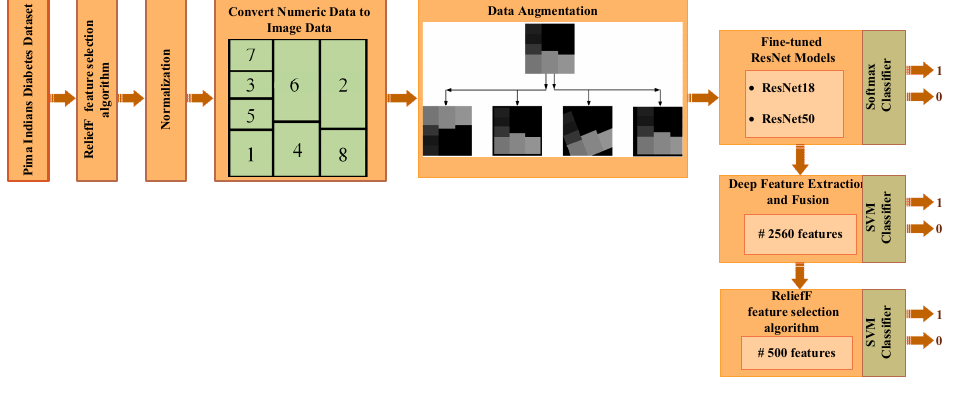
Figure 1. Application steps of proposed